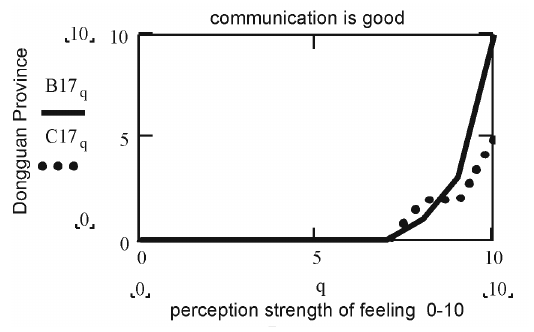
Fig. 4. Integrated perceptions (a single core